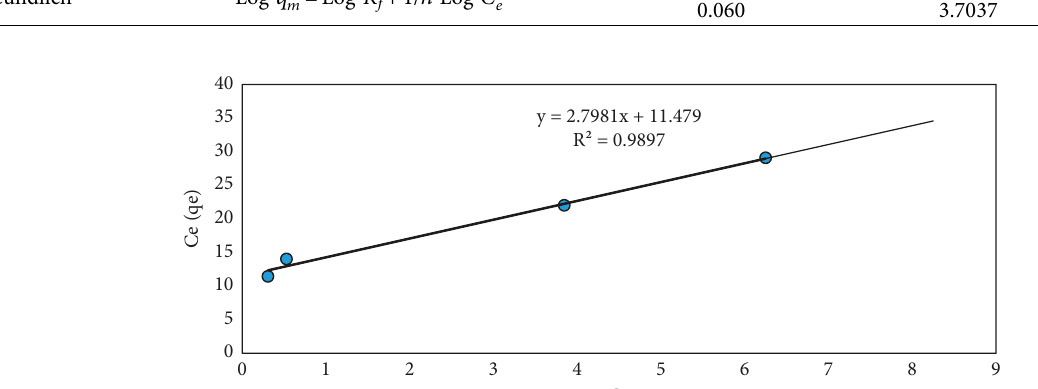
Figure 8: Langmuir isotherms for the as-produced MWCNTs-Fe